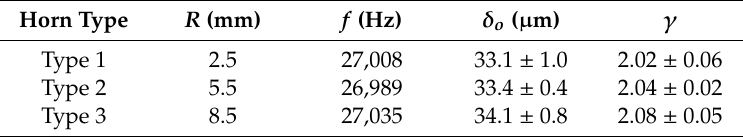
Table 2. Comparison of vibration characteristics for the three ultrasonic